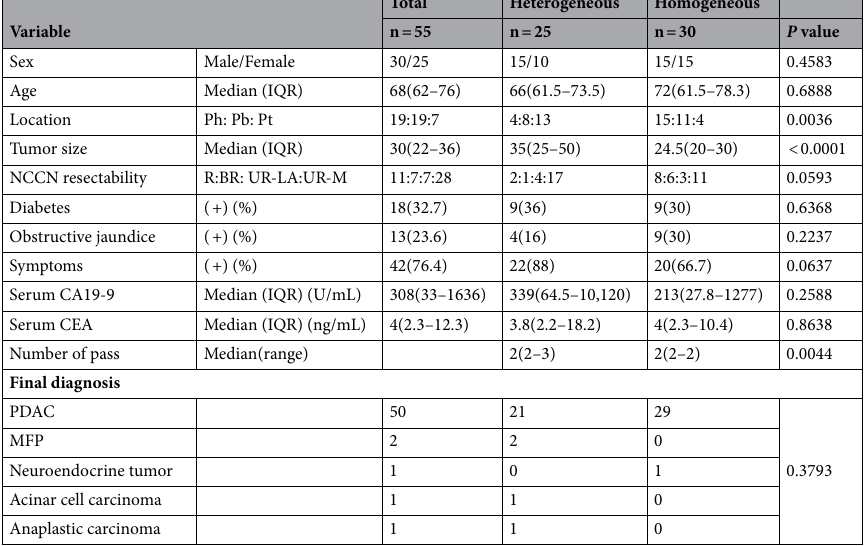
Table 1. Clinical Characteristics and final diagnosis of patients. NCCN National Comprehensive Cancer Network. R resectable, BR borderline resectable, UR-LA unresectable with locally advanced, UR-M